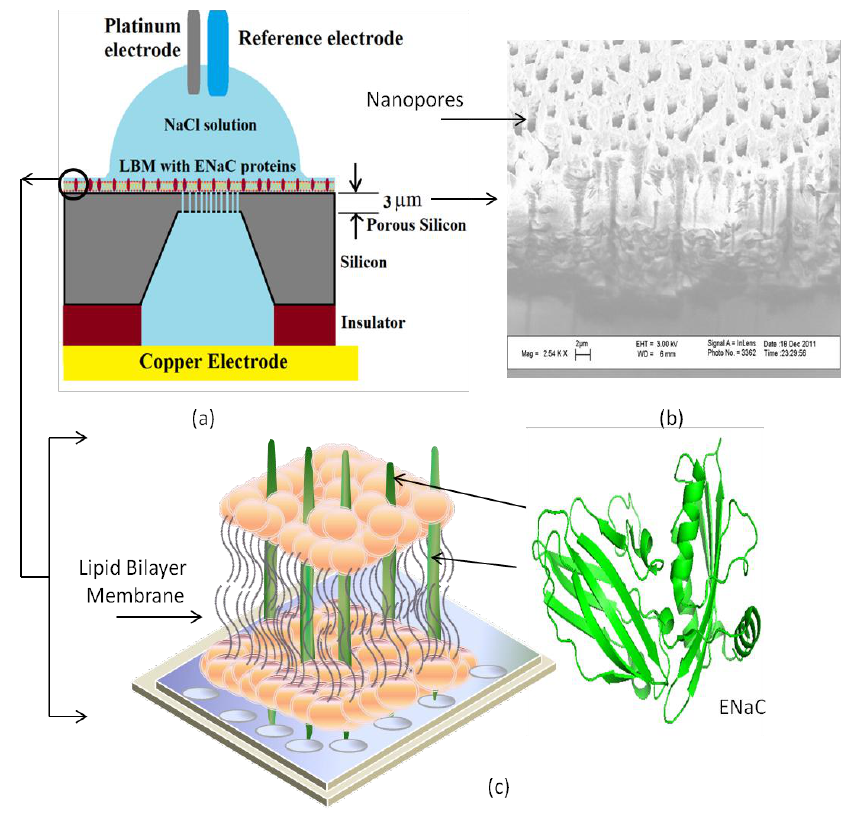
Figure 16. Illustration of experiment for porous silicon (PSi) device used for investigation of transmembrane protein fused in LBM. ( a ) Electrochemical cell formation; ( b ) Top-view of fabricated porous silicon using SEM; ( c ) Insight view of incorporation of ENaC with LBM on